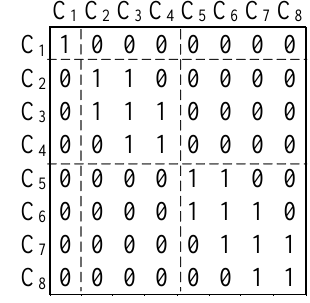
Figure 9. The separability matrix [ S ( C i , C j )